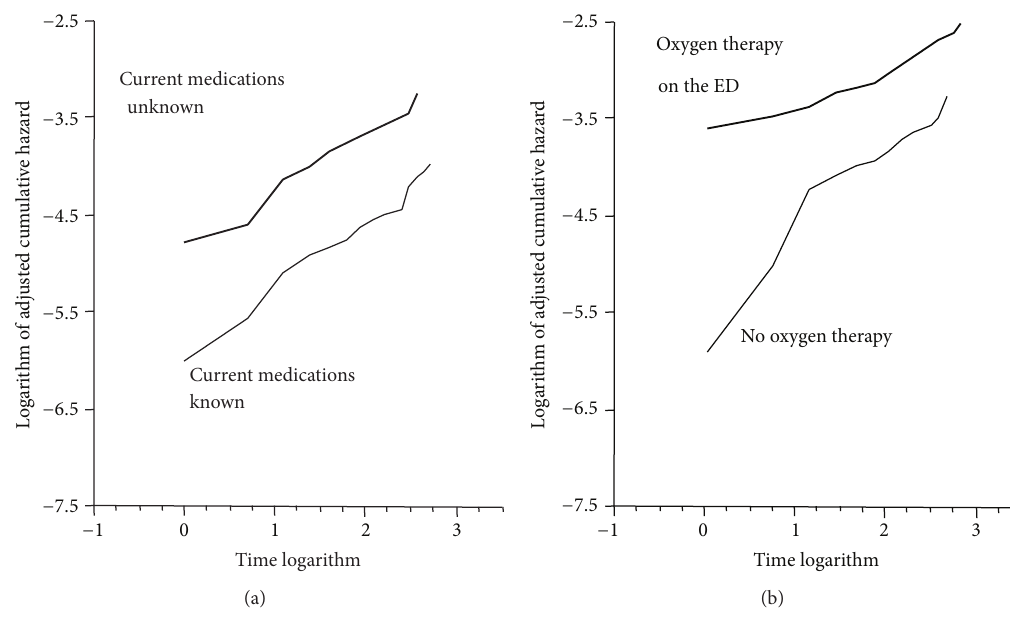
Figure 2: Cumulative hazard due to the variables “current medications unknown” and “oxygen therapy on the ED” plots the logarithm of the cumulative target event rate against the logarithm of time according to the presence or not of the variables current medications unknown (a) and oxygen therapy in the ED (b). It permits graphically verifying that the hazard ratios are independent of time approximately parallel curves. This was also examined for all other variables retained in the Cox model to ascertain that the assumption of hazard proportionality was not violated. ED: emergency